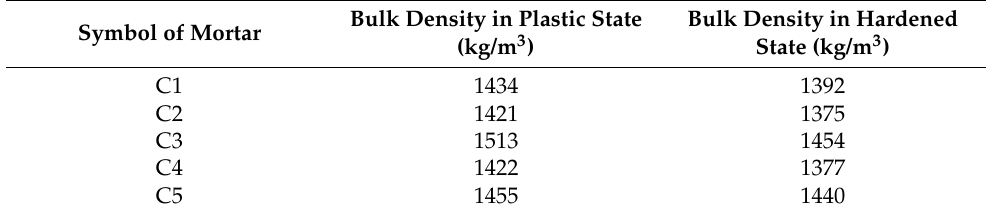
Table 6. Bulk density results.